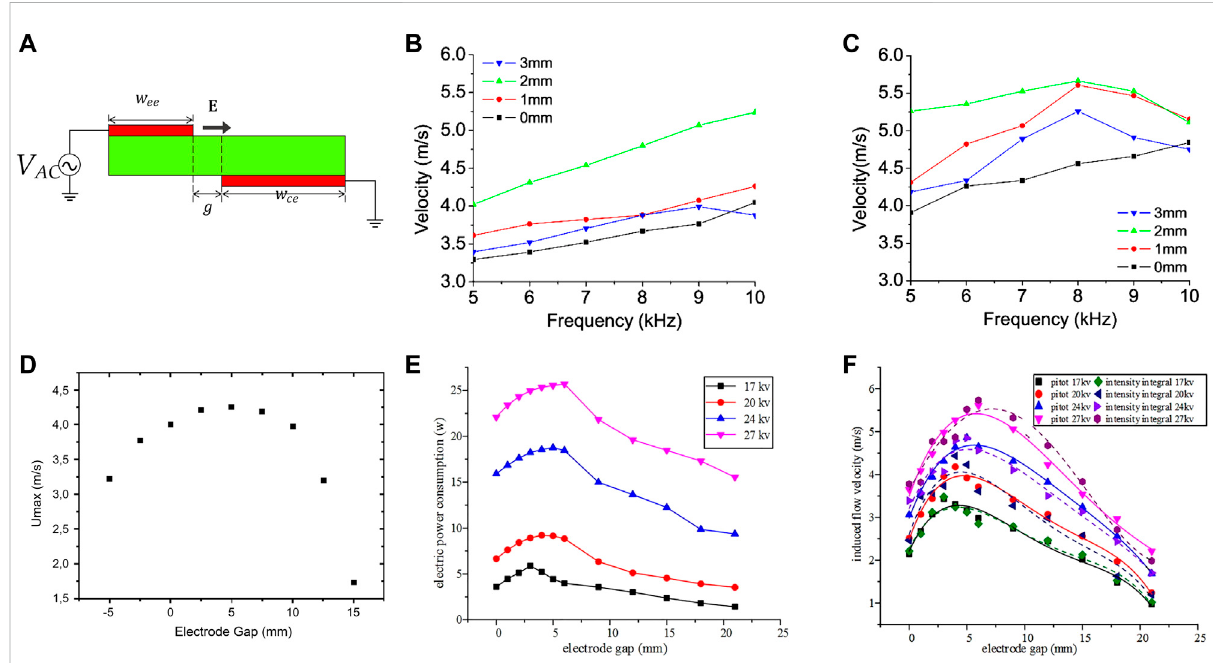
FIGURE 5 (A) Diagram of the horizontal gap between electrodes. (B) Induced fl ow velocity as a function of frequency and electrode gap, RMS voltage = 7 kV (~19.8 kVpp). (C) RMSvoltage=9 kV(~25.5 kVpp).Electrodegapsofg=0,1,2,and3 mmforbothcases[62]. (D)